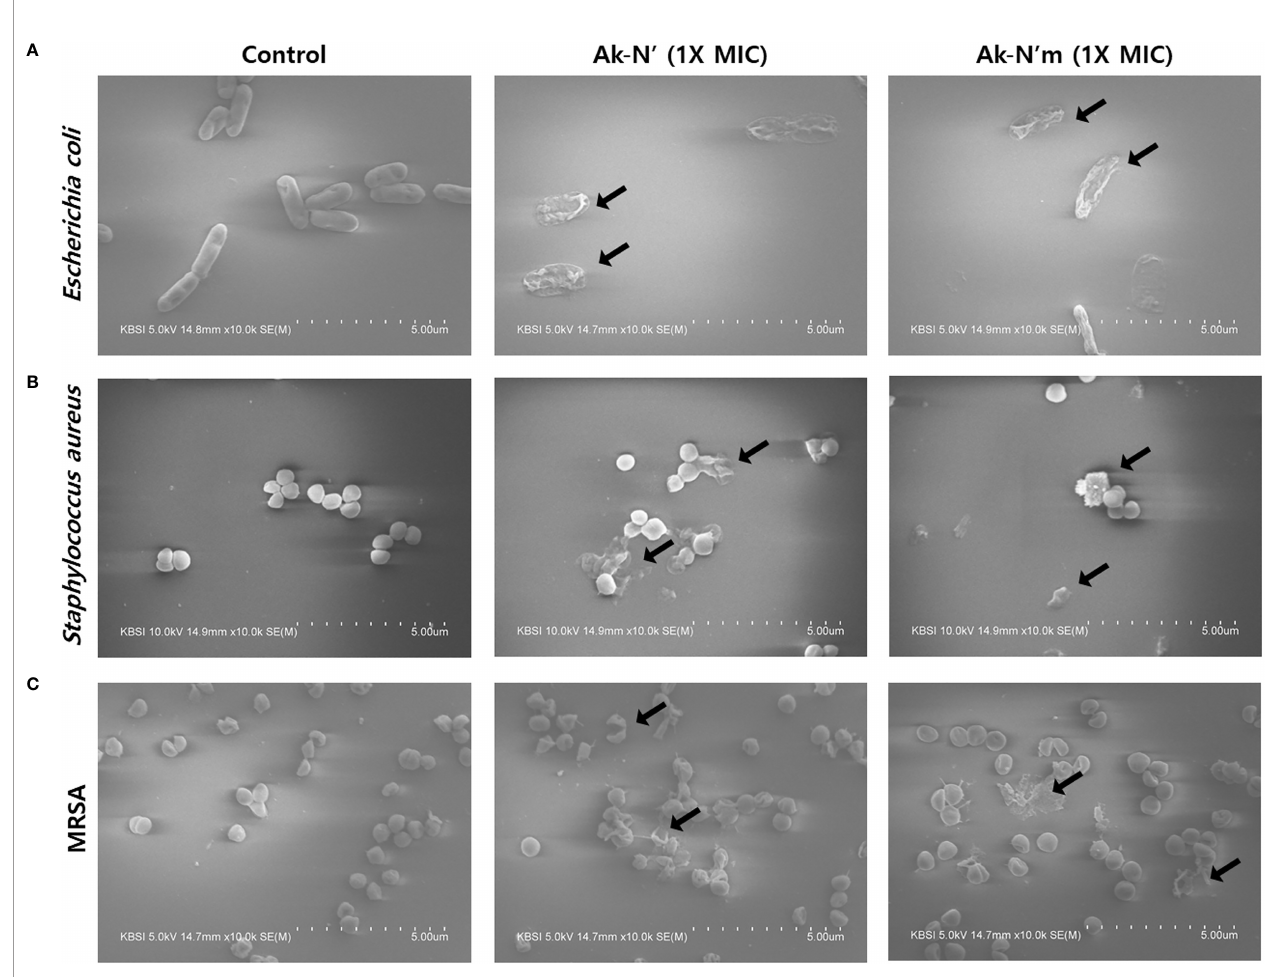
FIGURE 4 | Morphological changes of bacteria caused by Ak-N ’ and Ak-N ’ m. Effects on bacterial morphology upon peptide treatment was observed by FE-SEM imaging. When treated with 1 × MIC peptide for 2 h, (A) E. coli , (B) S . aureus , and (C) MRSA all showed damage to bacterial membranes with blebs and ruptures compared with the negative control treated with an equal volume of